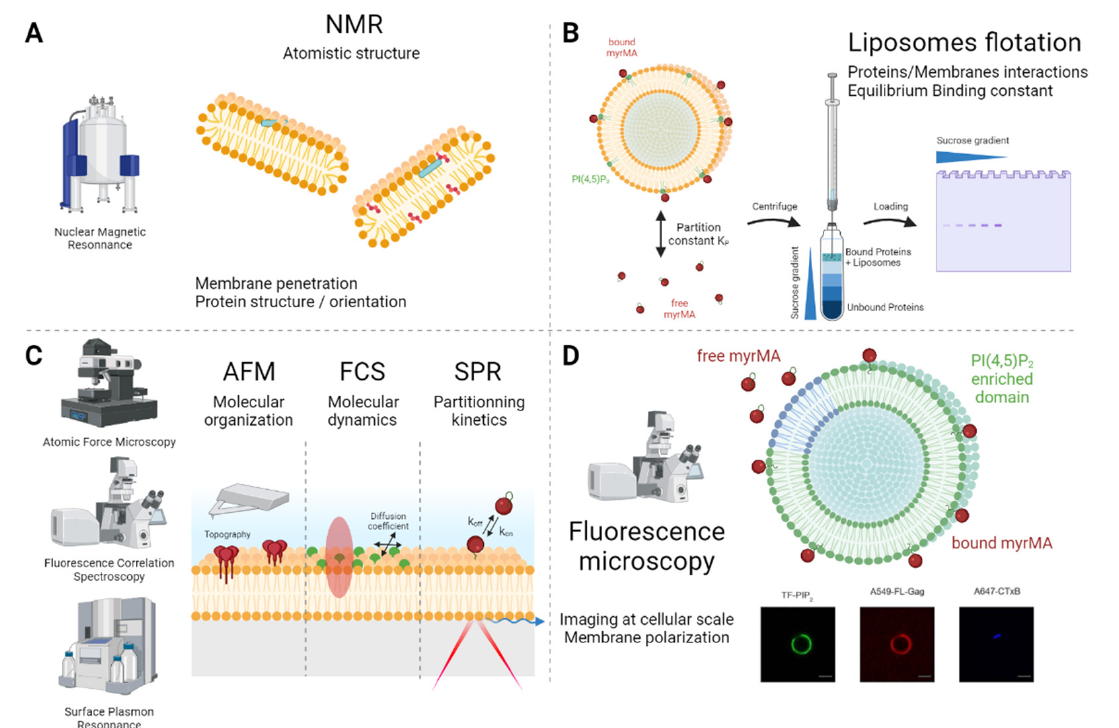
Figure 3. Methods and techniques for viral assembly study in several membrane model systems. ( A ) Bicelles are widely used models for protein structural analysis by NMR. ( B ) Liposome flotation unveils partition constant of a protein at a membrane’s surface using LUVs or SUVs. ( C ) Using the SLB planar system, AFM gives topographic information at a molecular level, FCS enables study of molecular dynamics and SPR is a way of studying binding properties. ( D ) GUVs are close in size and shape to cells, and one can, for instance, image protein– ‐ lipid co ‐ localizations at a cellular scale.